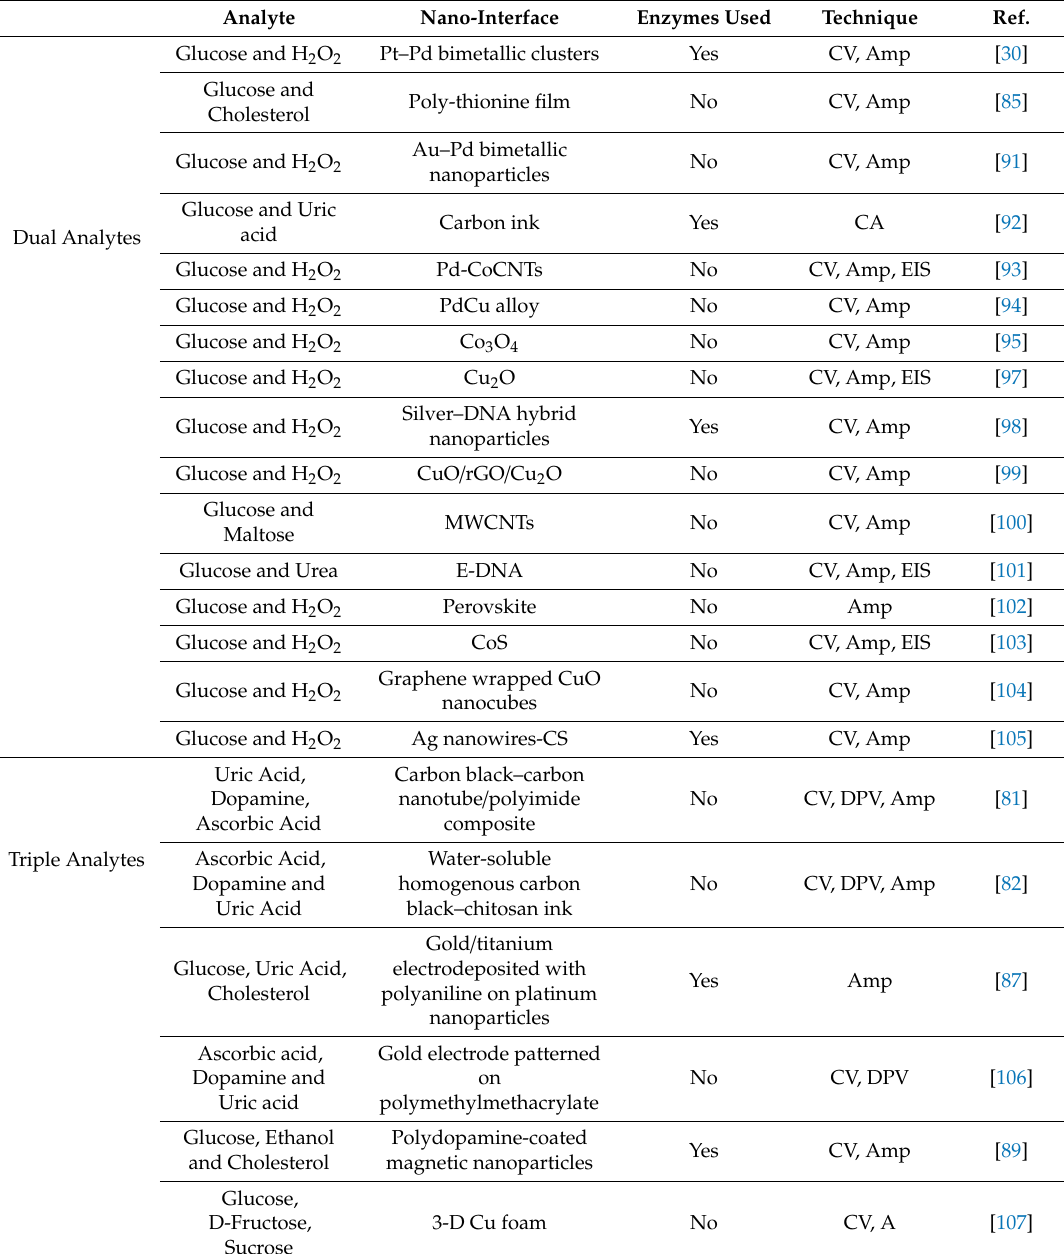
Table 3. Electrochemical sensors reported for sensing of dual and triple analytes